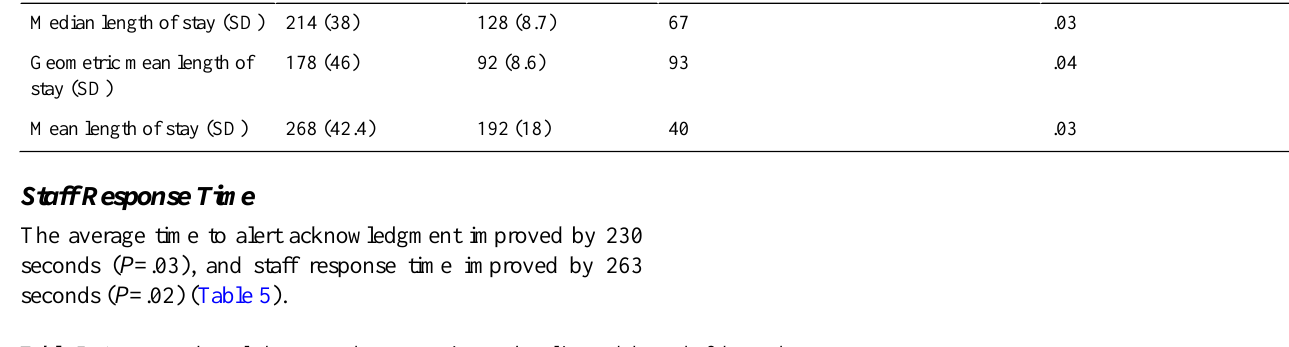
P valueDifference in CarePredict vs control (%)ControlCarePredictCommunity